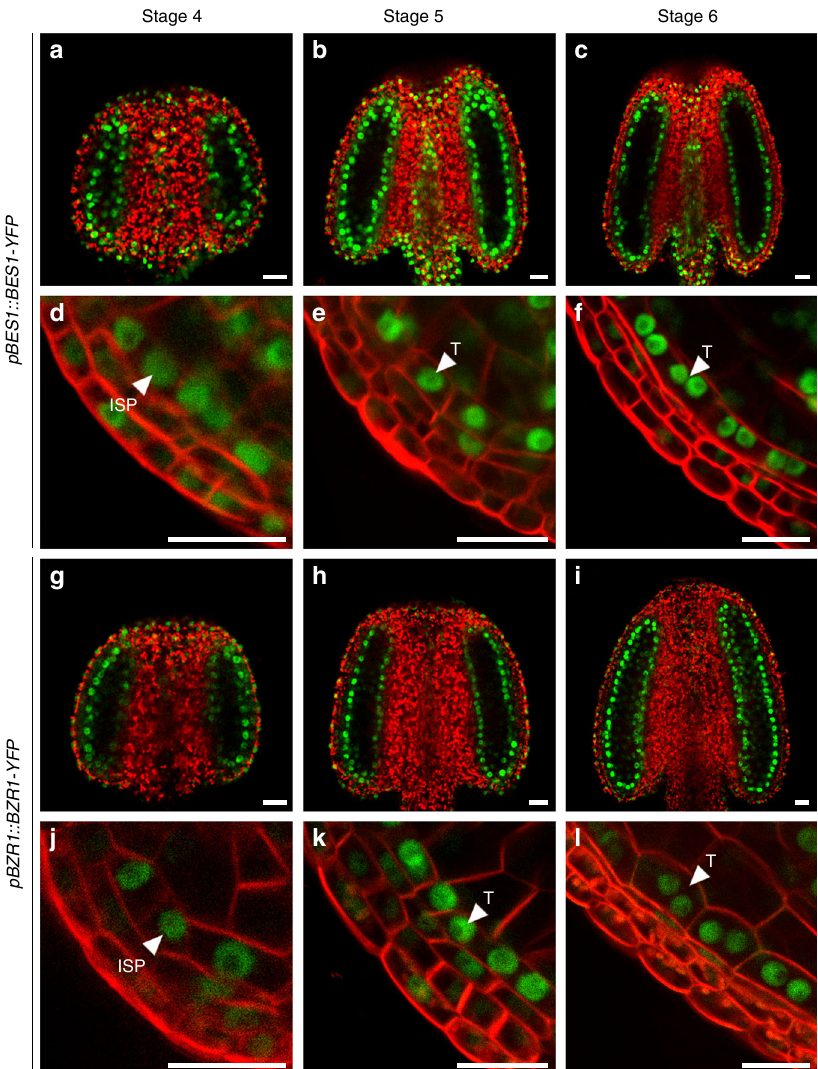
Fig. 4 BES1-YFP and BZR1-YFP can be detected in the developing anthers. Seven-week-old pBES1::BES1-YFP ( a – f ) and pBZR1::BZR1-YFP ( g – l ) transgenic plants were used for confocal microscopic analyses. Stage 4 – 6 intact anthers were selected for analyzing the YFP signals. Green colors represent YFP signals and red colors are the auto- fl orescence of chlorophylls ( a – c , g – i ). To visualize detailed tissue-level localization of the YFP signal, somatic cell membranes were stained with FM4-64 ( d – f , j – l ). Inner secondary parietal cell layer (ISP) and tapetum (T) are indicated by arrow heads. Scale